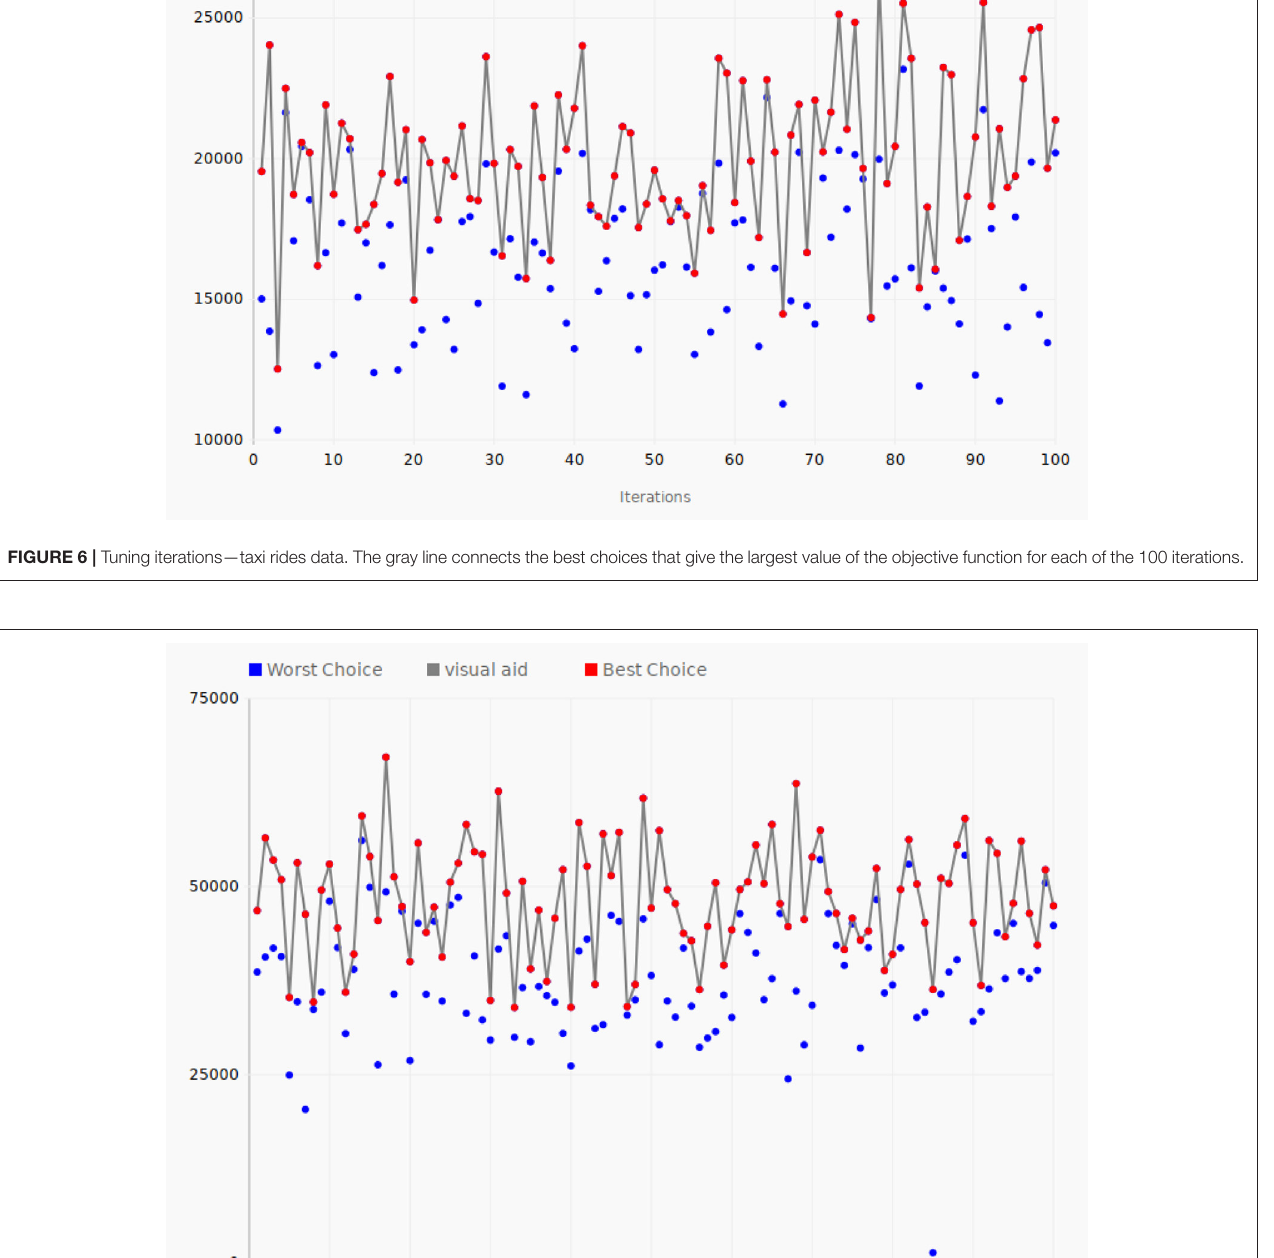
Frontiers in Big Data |